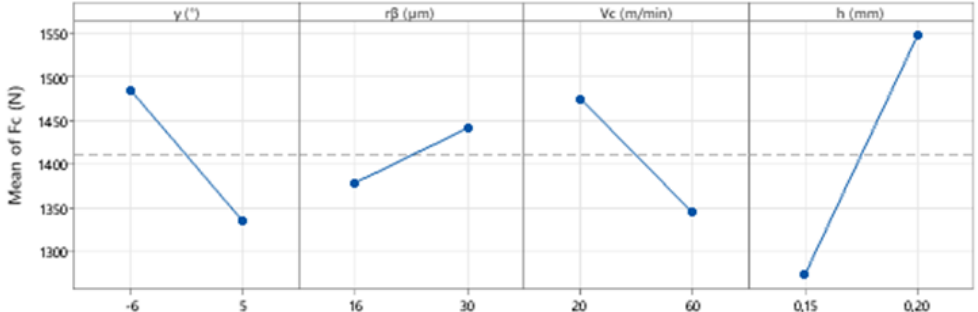
Figure 6. Influence of the cutting parameters on the cutting force ( F c ) based on all cutting conditions.